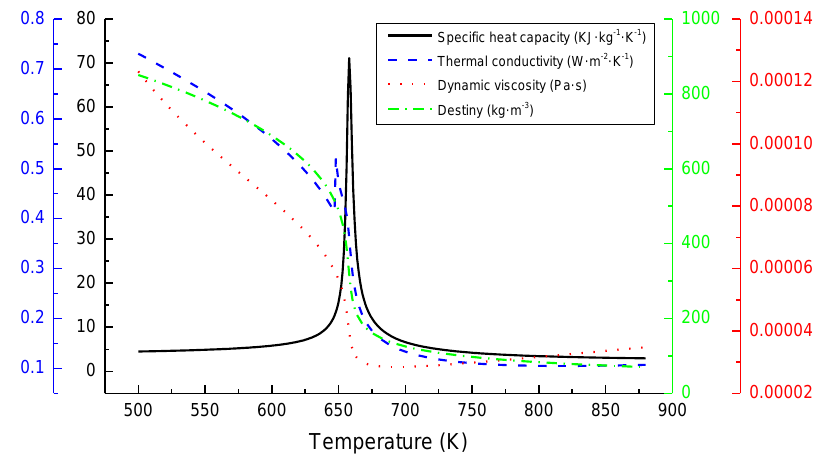
Figure 2. Properties of supercritical water (25 Mpa).